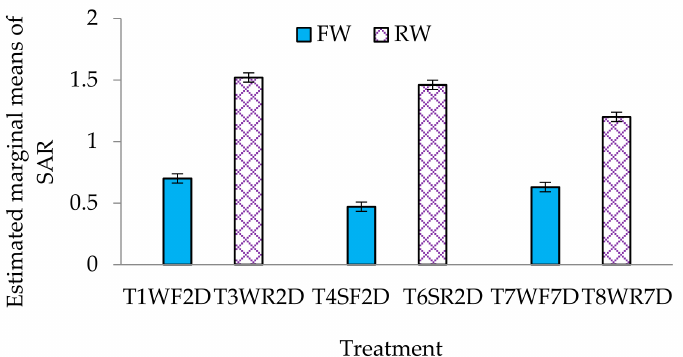
Figure 6. Estimated marginal means of sodium absorption ratio (SAR). FW = fresh water, and RW = recycled water. Error bars indicate standard error. See Table 2 for treatment descriptions.